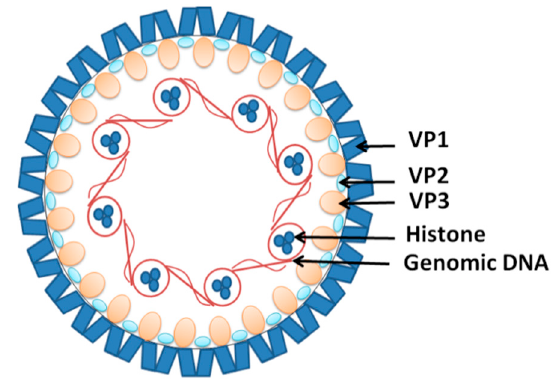
Figure 4. The structure of the John Cunningham virus (JCV). The viral DNA is packed around the histones in a chromatin-like complex. It is covered by viral structural proteins VP1, forming the capsid with the VP2 and VP3 proteins incorporated.